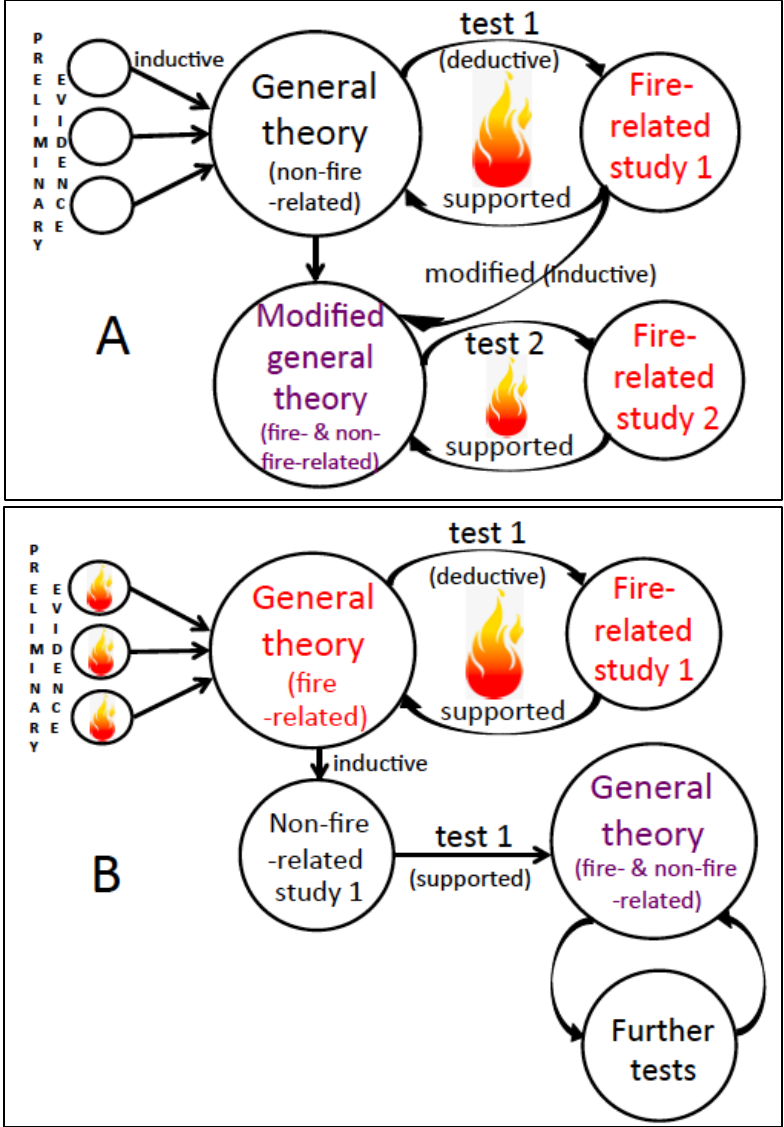
Figure 3. Procedures for testing the generality of theories and models developed initially for A) non-fireprone systems (to determine if they also apply to fireprone systems) and B) fireprone systems (to determine if they also apply to non-fireprone systems). It is most likely that systems that experience recurrent disturbance will conform with scenario